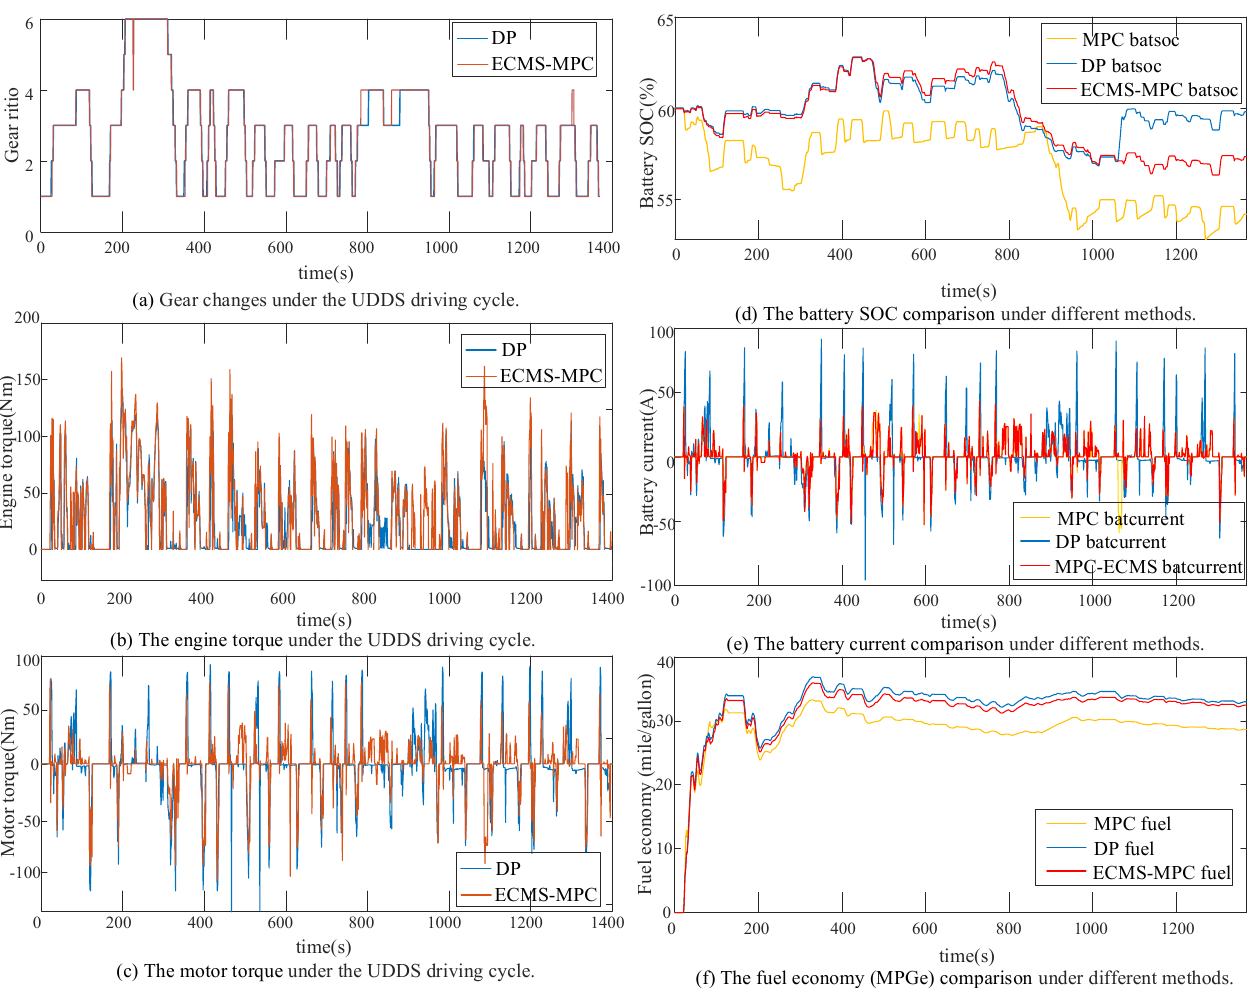
Figure 9. ( a – c ) The applied UDDS driving cycle and simulation in ECMS-MPC (5 s) and DP. ( d – f ) Comparison of the battery SOC and current when using different energy management strategies in the UDDS driving